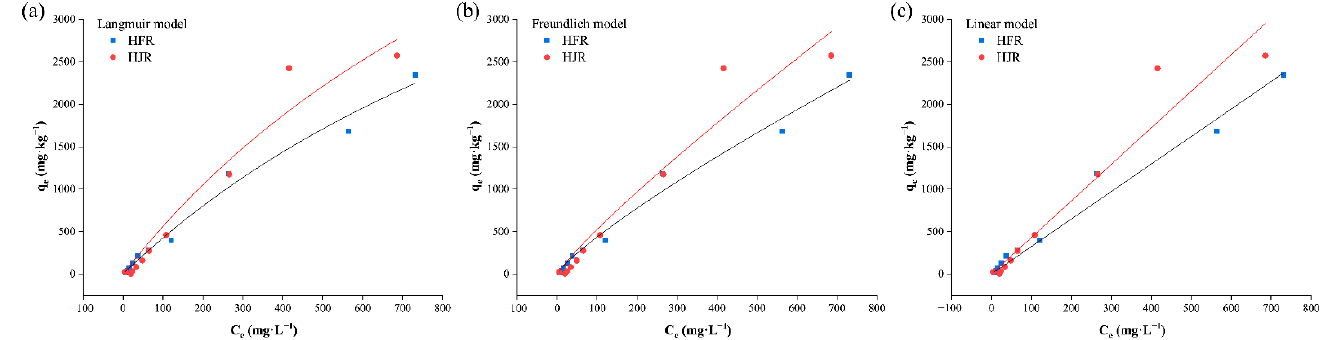
Figure 10. Models fitted to data related to adsorption of soil from profiles at depths of 700 to 900 mm within SIA for Cr (VI) (( a ) is the curve fitted to the Langmuir equation, ( b ) is the curve fitted to the Freundlich equation, and ( c ) is the curve fitted to the Linear equation). Table 6. Fitting parameters of isothermal adsorption models of soil from the profile at depths of 700 to 900 mm within SIA for Cr (VI).